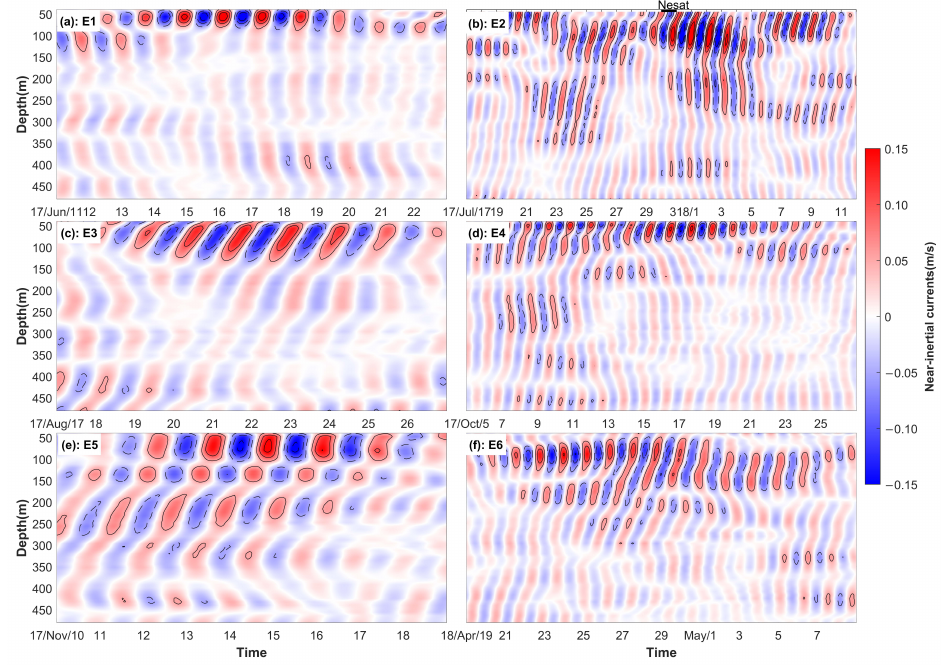
Figure 9. Zonal near-inertial currents of the six NIWs episodes. Figures ( a – f ) correspond to episodes 1 to 6. The contours start at ± 0.05 m/s with intervals of 0.05 m/s. In Figure ( b ), the passaging time of typhoon Nesat is denoted by the black rectangle in the